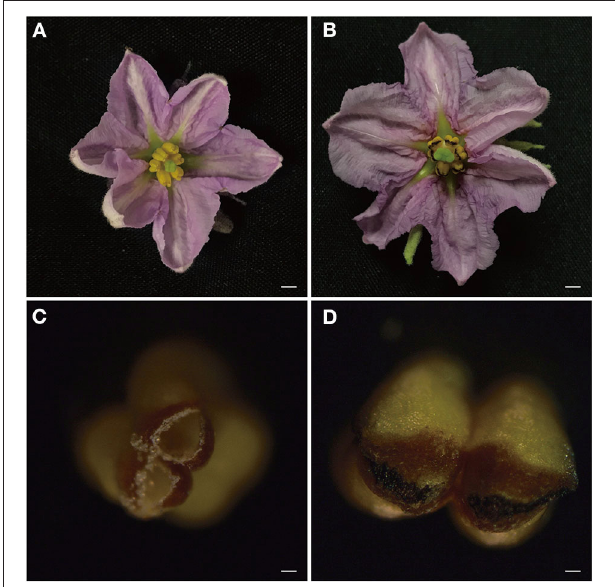
FIGURE 1 | Morphological analysis of Solanum melongena L. F142 and S12 flowers and anthers on the day of flowering. (A,B) The flower of F142 and S12. Bars = 5mm. (C,D) The anther of F142 and S12. Bars = 100 µ